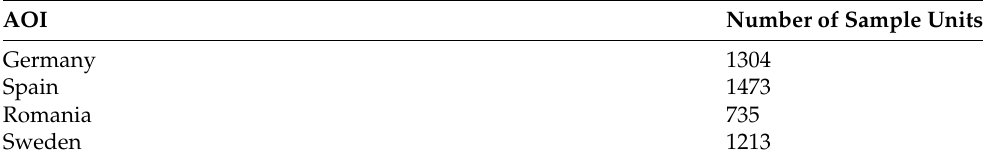
Table 3. Number of EEA validation data sample units (100 × 100 m) per country for the HRL IMD. AOI Number of Sample Units Germany 1304 Spain 1473 Romania 735 Sweden